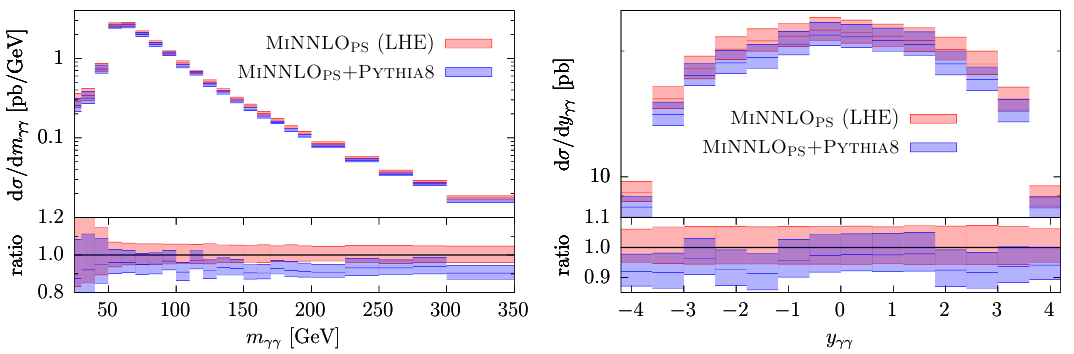
Figure 7 . Comparison between the distributions obtained from the Powheg events before and after the Pythia8 parton shower for the diphoton virtuality and